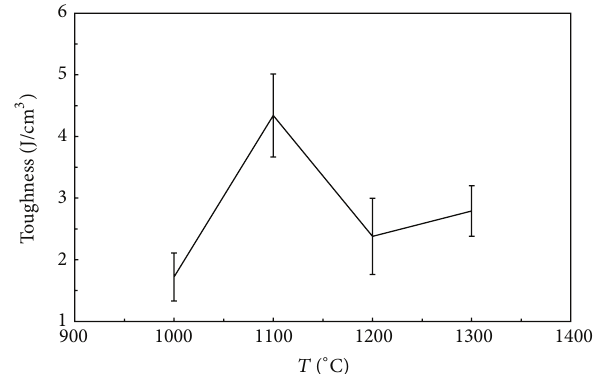
Figure 4: Influence of toughness of the BCP ceramics on sintering